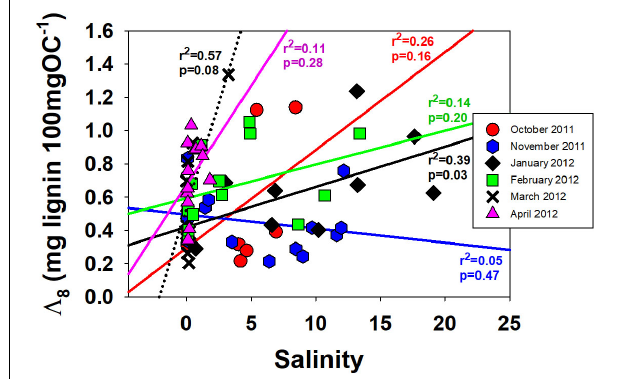
FIGURE 3 | Carbon-normalized lignin yields, (cid:51) 8 , vs. salinity for each of the sampling months. Trend lines are included by each month to demonstrate generally higher values in the western stations, except for November.